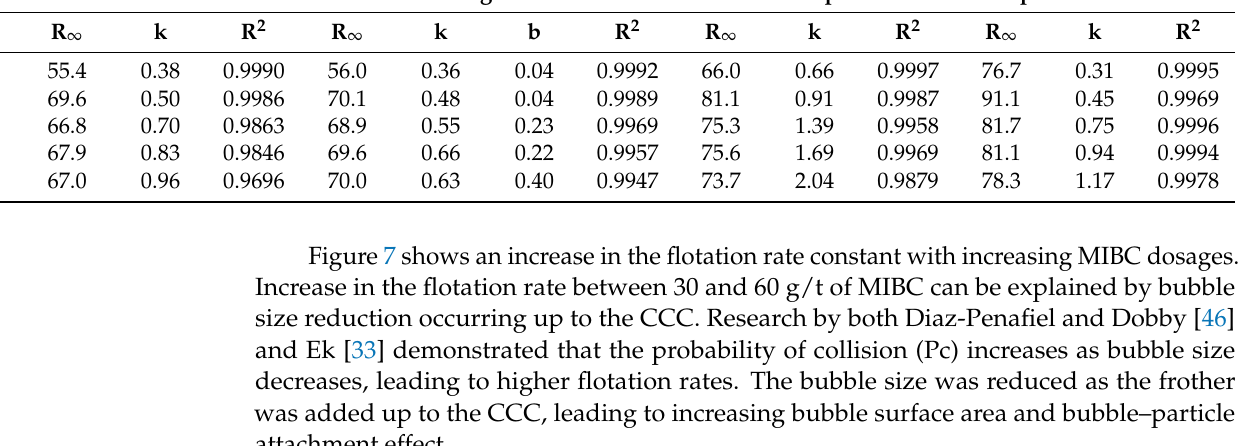
Table 4. Kinetic model fitting results: R ∞ (%), ultimate recovery; k (min − 1 ), rate constant; b (min), time correction factor. Classical Agar Klimpel Improved Gas/Solid